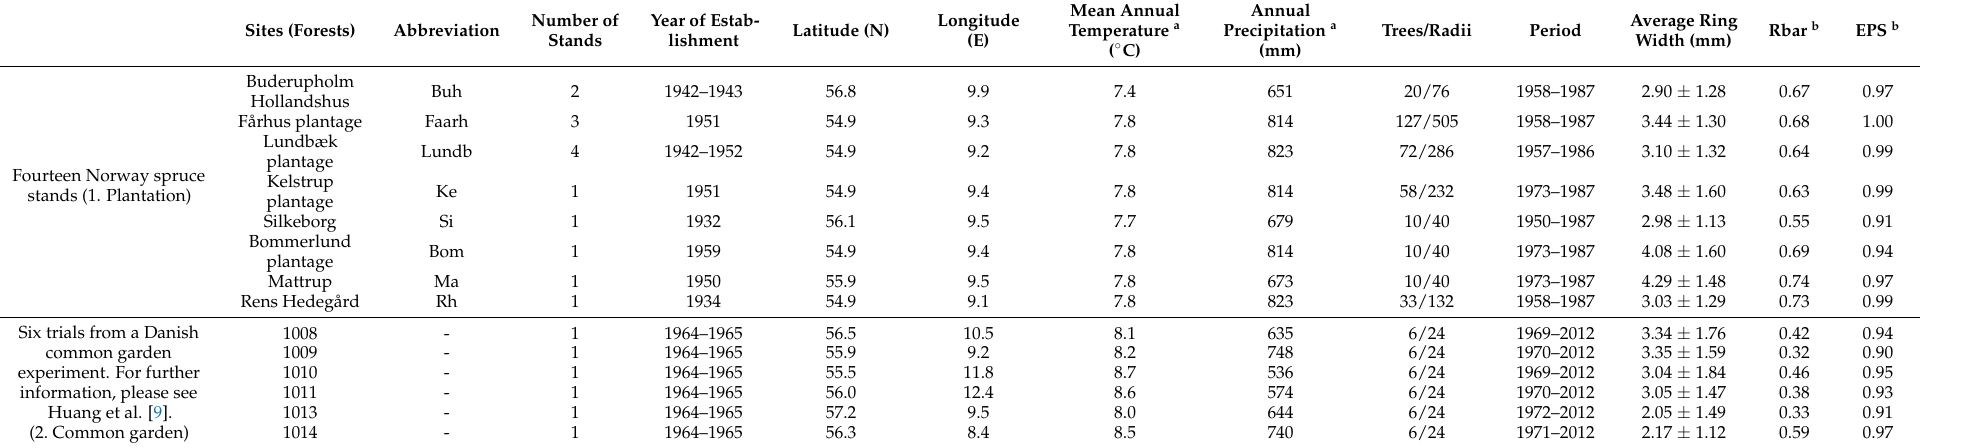
Table 1. Overview and main characteristics of the studied Norway spruce